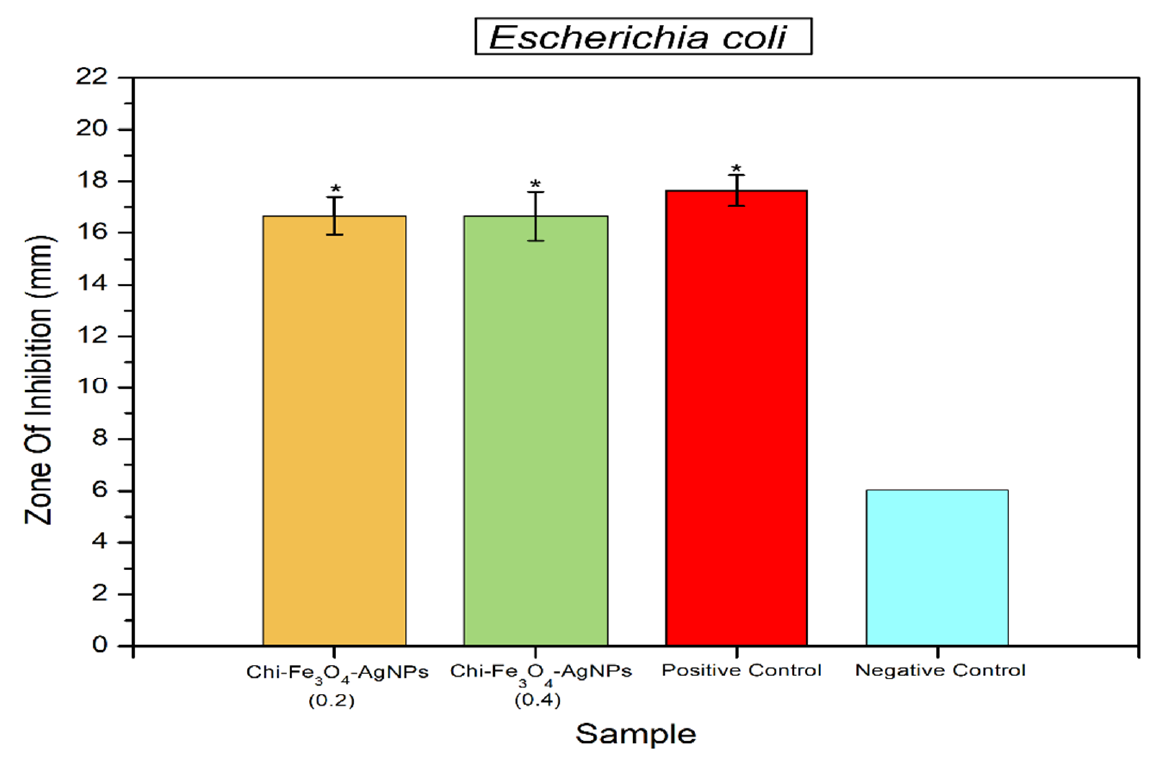
Figure 9. Antibacterial activity of Fe 3 O 4 @Chitosan-AgNPs against E. coli . Mean ± SD ( n = 3); * p < 0.05 significant change compared with the negative control